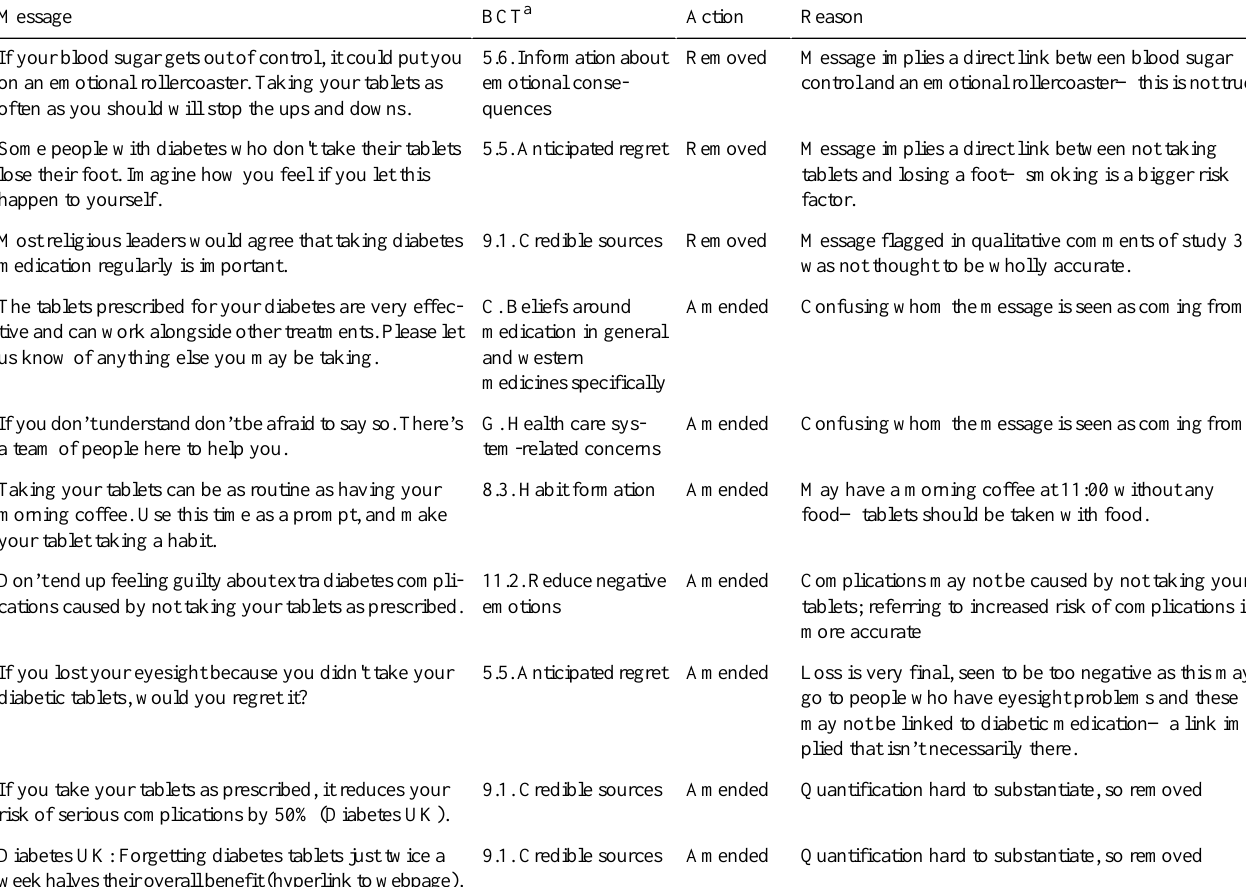
Table 6. Reasons for message removal or amendment following health care provider review.